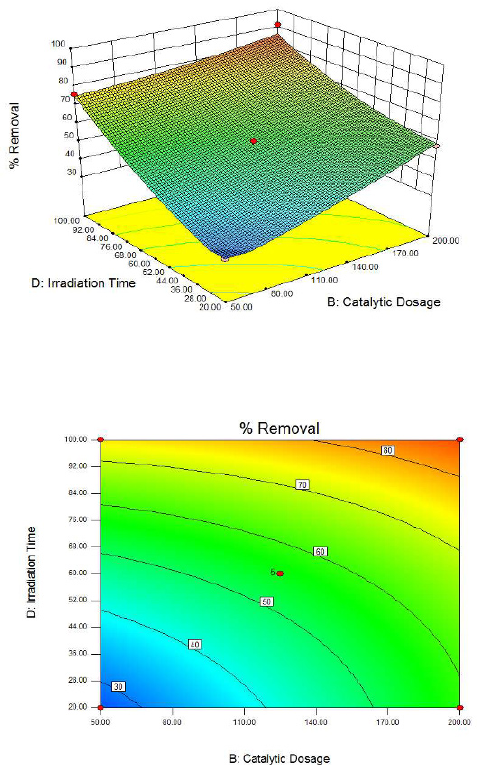
Figure 7. Response surface (Top) and contour plots (Bottom) show- ing the interaction between catalytic dosage and Irradi- ation time for solar induced photocatalytic decolouriza- tion of dye effluent (Dye effluent concentration 60 mg L − 1 ; pH 7).